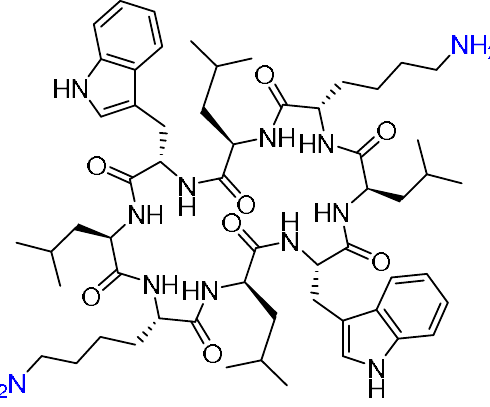
Figure 15. Chemical structure of the cyclic peptide comprising alternating L and D amino acids. Anchoring points are shown in blue.